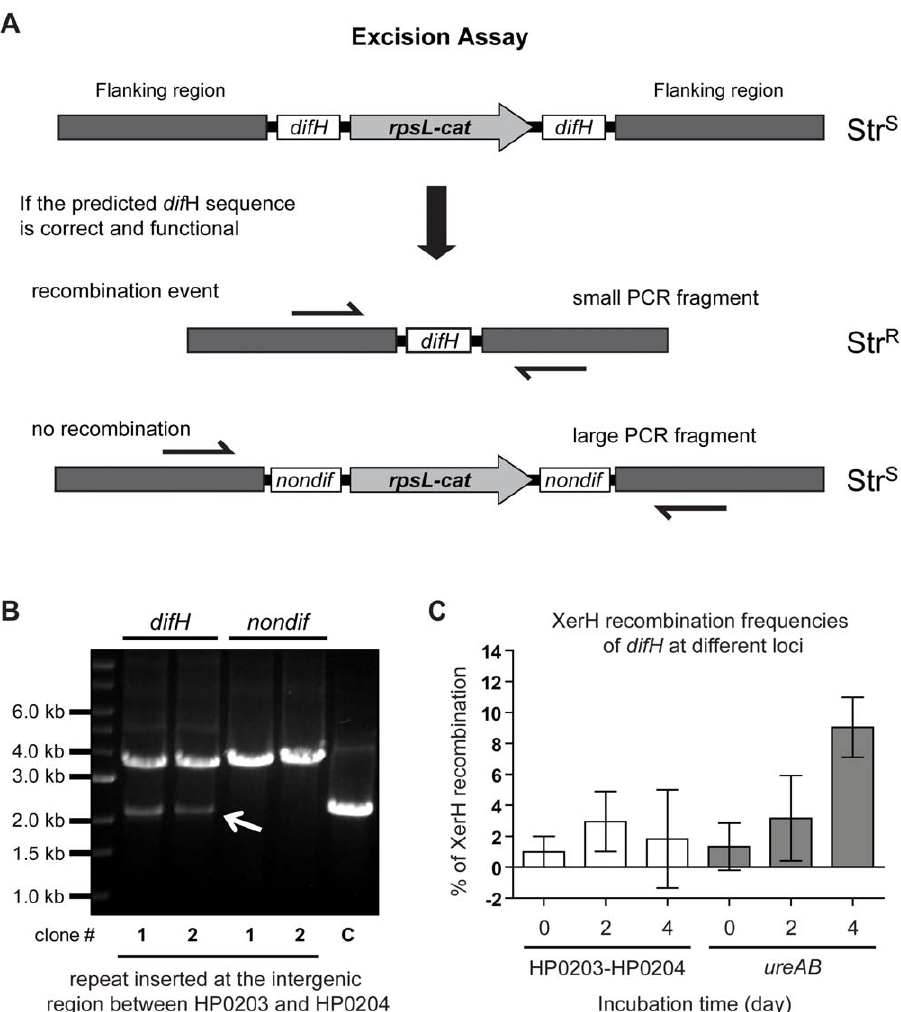
Figure 1. XerH/ difH site-specific recombination assay in Helicobacterpylori. (A) Schematic depiction of XerH excision assay. The difH repeat cassette, consisting of streptomycin susceptibility-chloramphenicol resistance genes ( rpsL - cat ) flanked by difH sequence, was introduced into the H. pylori 26695 Str (WT) genome by natural transformation and homologous recombination between genes HP0203 and HP0204 or in place of genes ureA and ureB . Recombination at difH sites leads to excision of rpsL - cat and one difH sequence, detectable by a PCR fragment 1.5 kb smaller than that from parental difH repeat cassette containing DNA. A cassette with nondif sequence flanking rpsL-cat served as a negative control. (B) Results of difH recombination assay in H. pylori 26695 Str (WT) with 40 bp difH direct repeats or 40 bp nondif DNA direct repeats at the HP0203-HP0204 locus. With each of these cassettes, two independent clones were tested by diagnostic PCR. The 2.1 kb and 3.6 kb PCR products come difH recombinant and parental ( difH repeat containing) DNAs, respectively. Lane C, control from wild-type H. pylori without difH repeat cassette. (C) difH recombination frequencies for difH repeat cassette located at HP0203-HP0204 or ureAB loci. Cells were grown on non-selective media for two or four days, re- streaked for single colonies, and , 100–200 colonies were tested for retention or loss of rpsL and cat genes by replica plating to streptomycin and